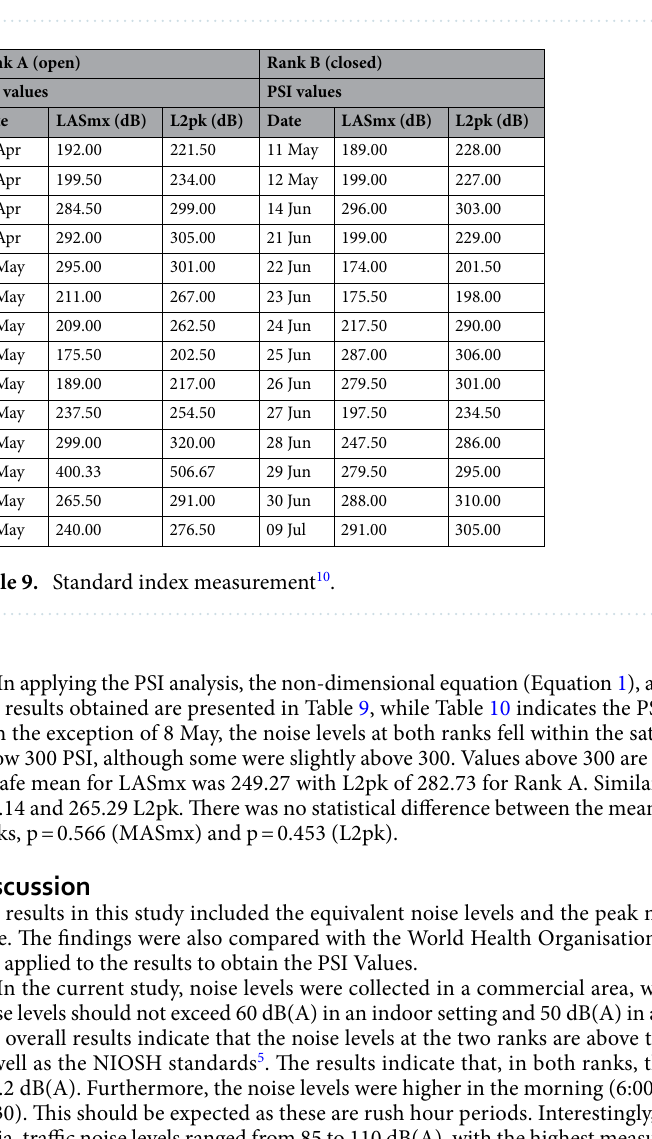
Table 8. Noise measurements recorded at Rank